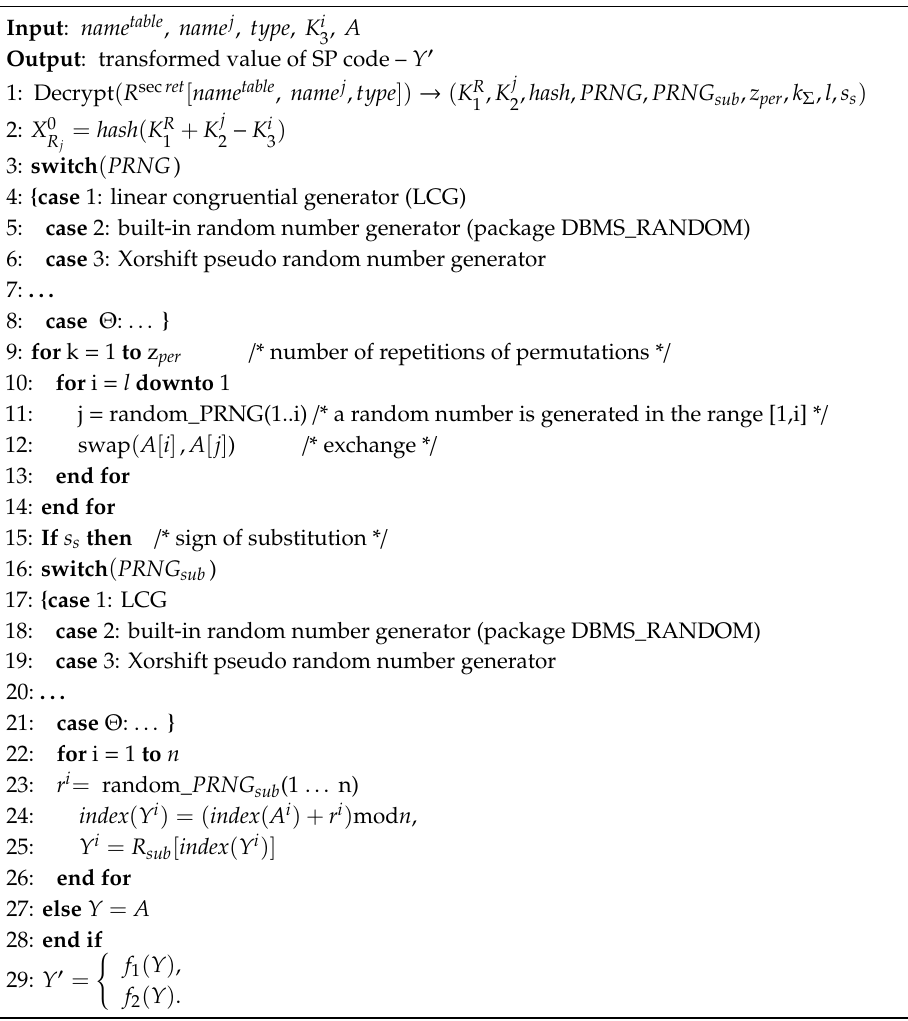
Algorithm 2. Masking algorithm P